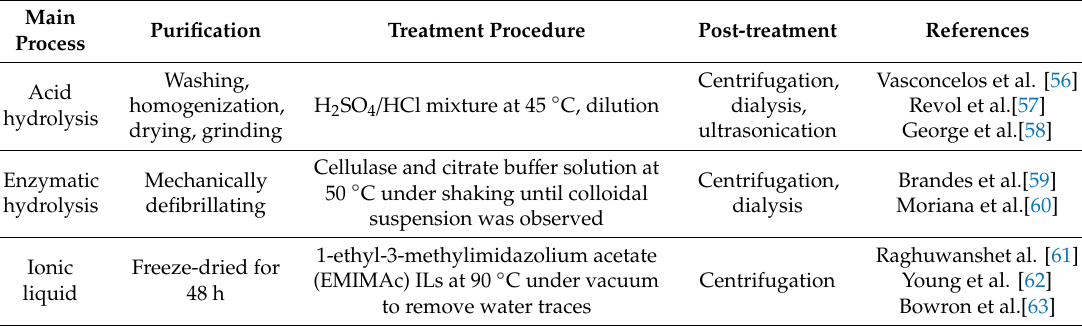
Table 1. Nanofication procedure of bacterial cellulose.